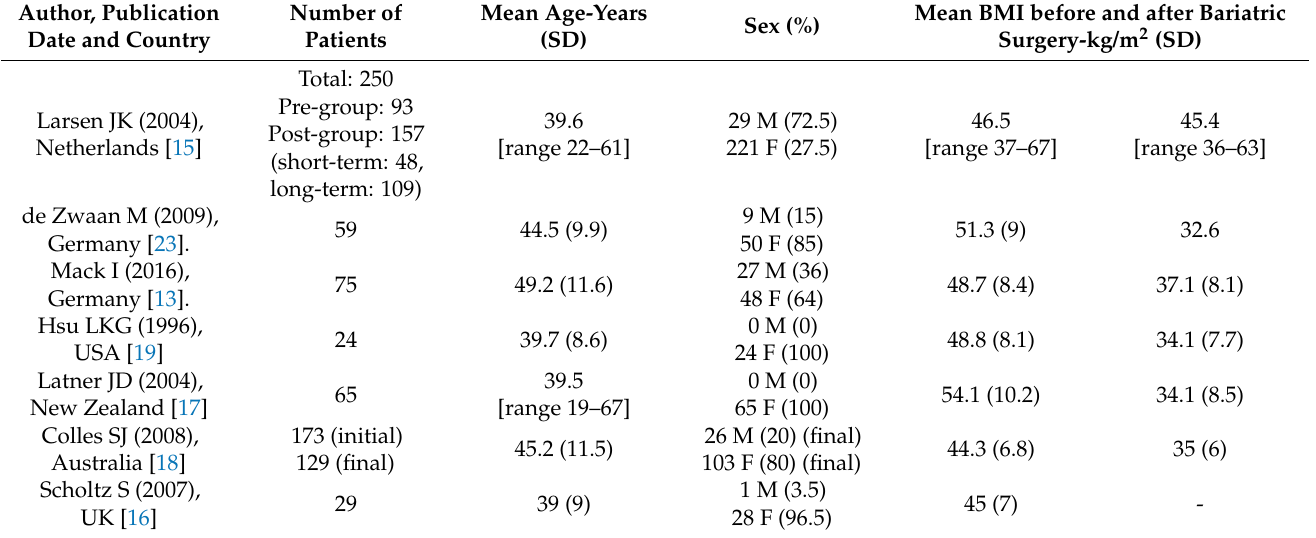
Table 1. Demographic characteristics of